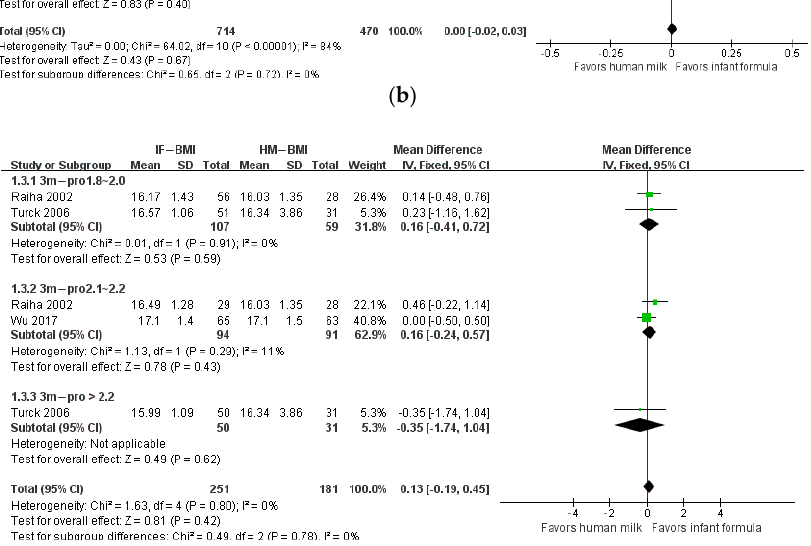
Figure 4. Forest plot of the effects of protein content of infant formula on the weight gain, height gain, and BMI of infants at 3 months of age. ( a ) The effects on weight gain. ( b ) The effects on height gain. ( c ) The effects on